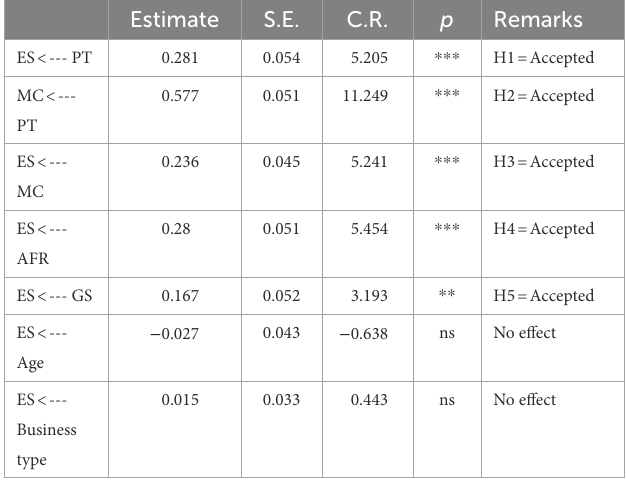
TABLE 5 Hypotheses